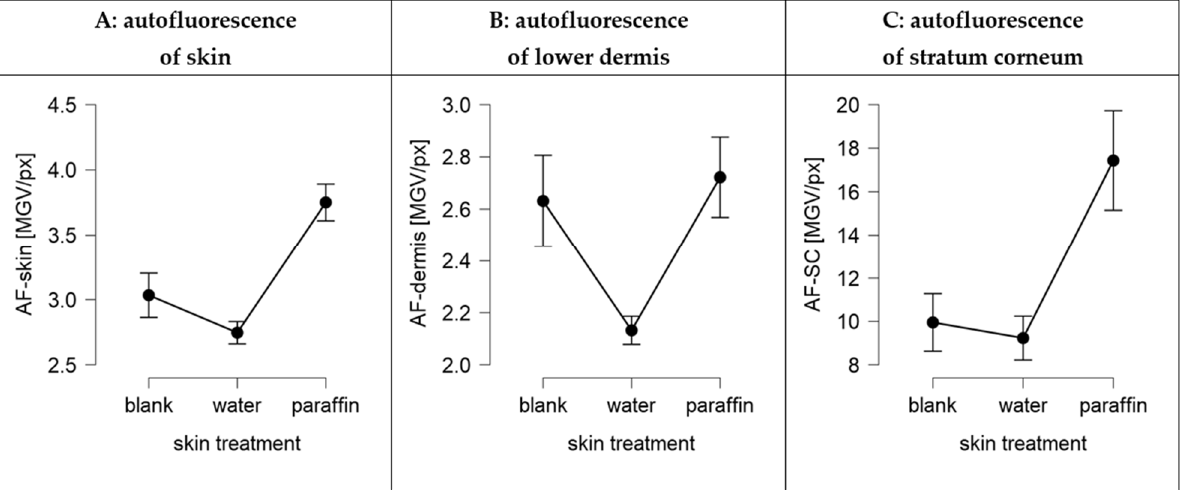
Figure 11. Changes in autofluorescence of skin sections upon application of paraffin or water on skin with massage in comparison to untreated massaged skin (blank). ( A ): mean autofluorescence of complete image, ( B ): mean autofluorescence of lower viable dermis of stratum corneum, ( C ): mean autofluorescence of stratum corneum (cf., Supplementary Materials, S3).